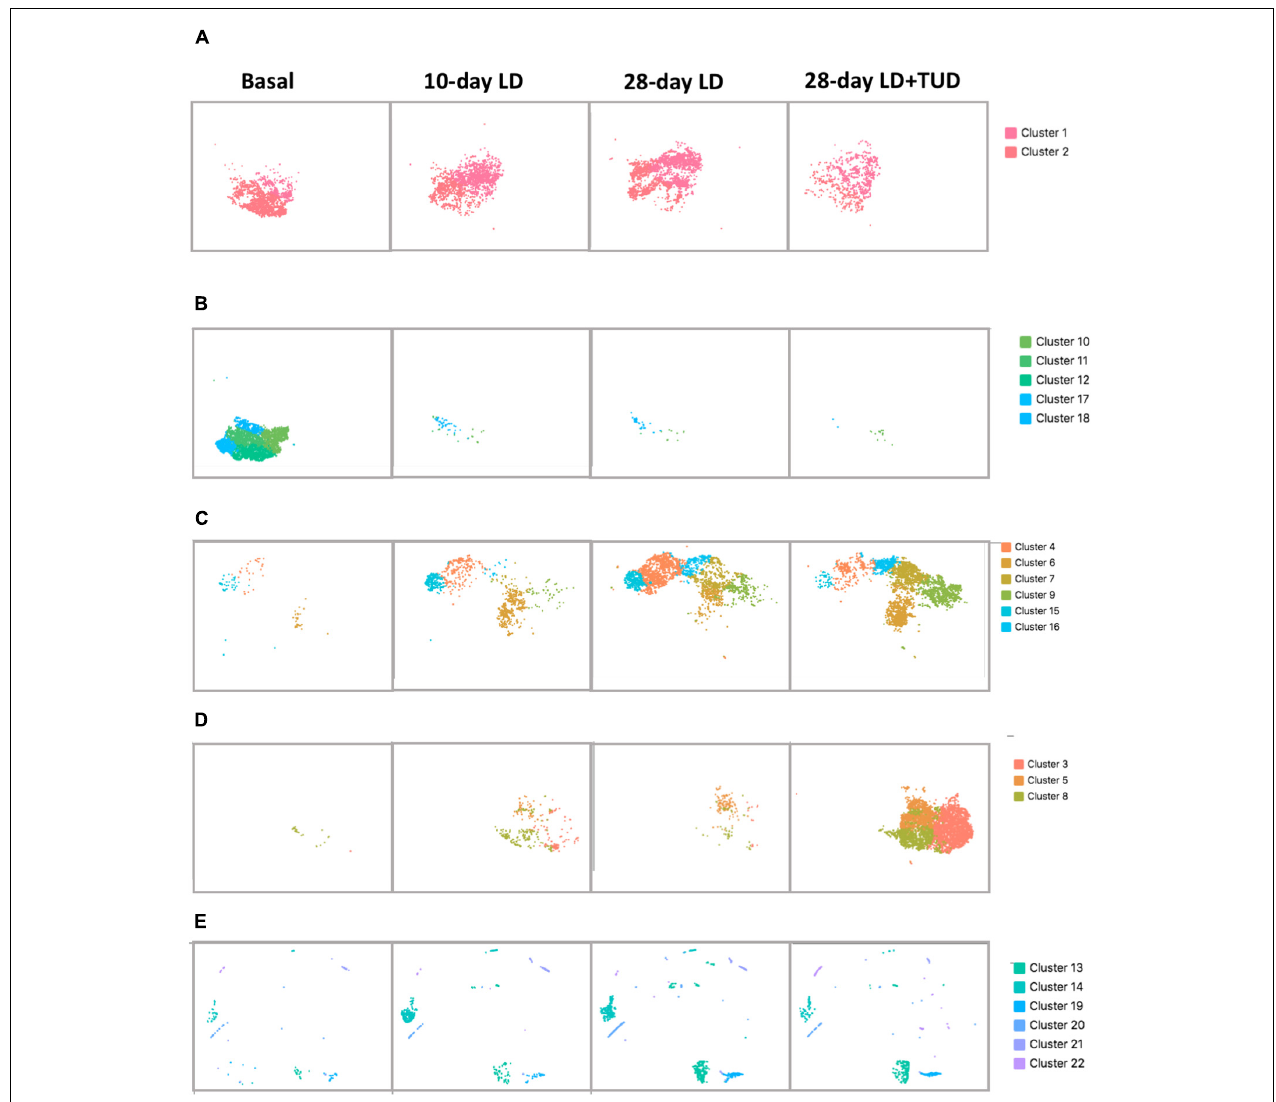
FIGURE 3 | Shifting of gallbladder cell clusters during lithegenesis. t-SNE plot demonstrating the dynamic transcriptomic patterns during the process of lithogenesis and with TUDCA treatment. Basal (day 0), day 10, and day 28 gallbladder cells during gallstone formation. (A–D) Epithelial cells. (E) Non-epithelial cells. (A) Clusters 1 and 2 were shared by all diet conditions suggesting the constant preserved clusters of epithelium cell in gallbladder irrespective of diet challenge. (B) Clusters 10, 11, 12, 17, and 18 were almost exclusively present under basal condition and disappeared after LD. (C) Clusters 4, 6, 7, 9, 15, and 16 appeared in response to LD. (D) Clusters 3, 5, and 8 were more related with TUDCA treatment. (E) Clusters 13, 14, 19, 20, 21, and 22 were non-epithelial cells changed under lithogenic diet and with TUDCA